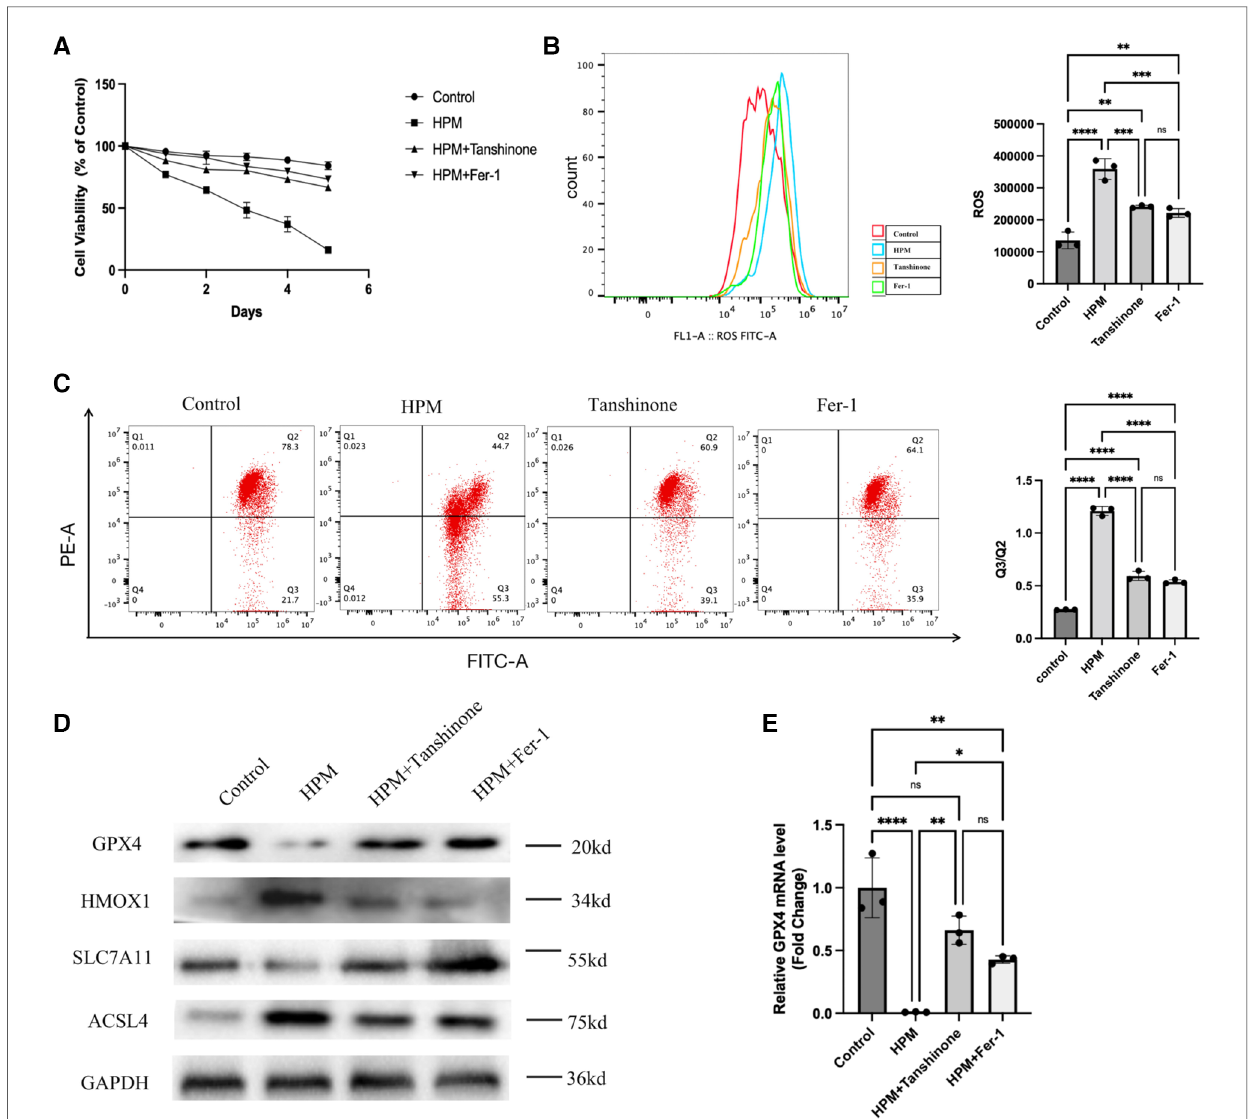
FIGURE 6 Tanshinone and Fer-1 inhibit ferroptosis in cardiomyocytes. ( A ) Cardiomyocytes cells were treated with Tanshione or Fer-1, and the cell viability was measured by MTS assay from 0 to 5 day after HPM. ( B ) ROS assay was performed in the cardiomyocytes treated with Tanshione or Fer-1. Representative fl ow cytometry dot plots (left) for cardiomyocytes cells and quantitative analysis (right). Data represent mean±SD. ns, not signi fi cant; **, P<0.01,***, P<0.001,****, P<0.0001, one-way ANOVA, post hoc comparisons, Tukey ’ s test. ( C ) JC-1 Mitochondrial Membrane Potential Assay Kit performed in the cardiomyocytes. d)Protein levels of GPX4, HMOX1, ACSL4, SLC7A11 from the cardiomyocytes were analyzed with Western blot. ( E ) qRT-PCR analysis of GPX4 mRNA level was done in the cardiomyocytes. **, P<0.01, one-way